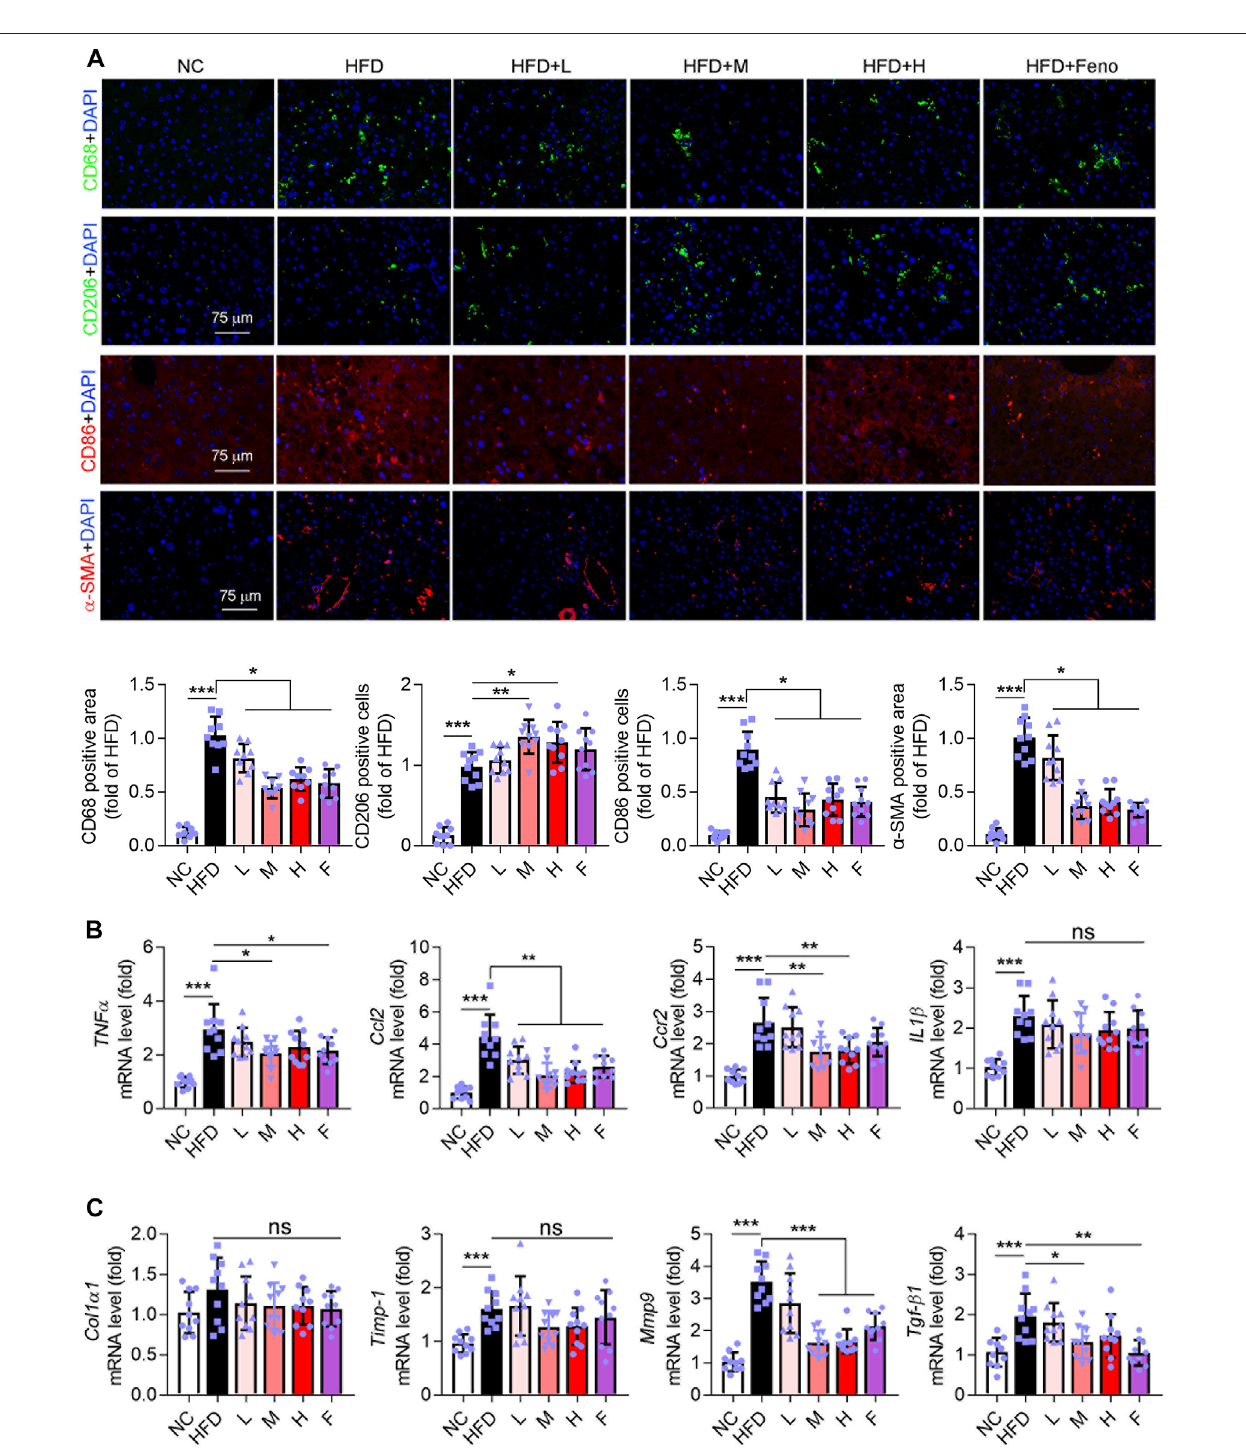
FIGURE 2 | Ganweikang tablet inhibits hepatic in fl ammation and fi brosis in NAFL mice. (A) Immuno fl uorescence staining for CD68 (green), CD206 (green), CD86 (red), α -SMA (red), and DAPI (blue) in liver sections from NC, HFD, HFD + L, HFD + M, HFD + H, and HFD + Feno group, followed by the quantitative analysis below. (B) The fold changes of TNF α , Ccl2 , Ccr2 , and IL1 β mRNA in the liver from the indicated group ( n = 10 mice examined per group). (C) The mRNA fold level changes of Col1 α 1 , Timp-1 , Mmp9 , and Tgf- β 1 intheliver from thegroup asindicated (n=10mice examinedper group). * p < 0.05, ** p < 0.01, *** p < 0.001,byone-wayANOVA with Bonferroni correction. ns, no signi fi